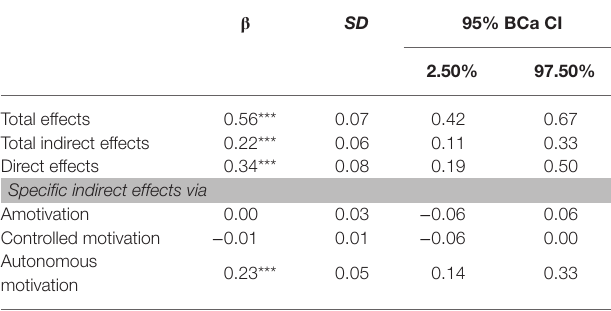
TABLE 3 | The relationship between purpose and work engagement as mediated by autonomous